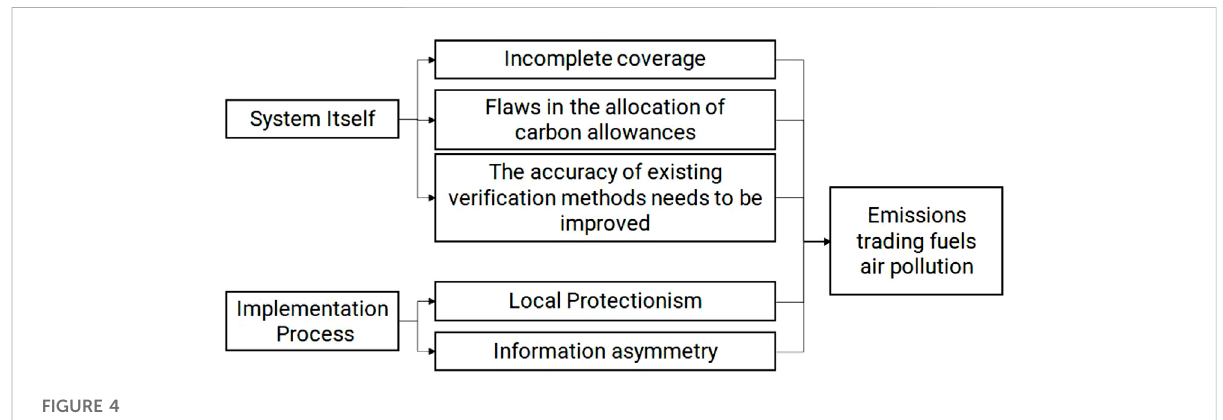
FIGURE 4 Mechanism analysis